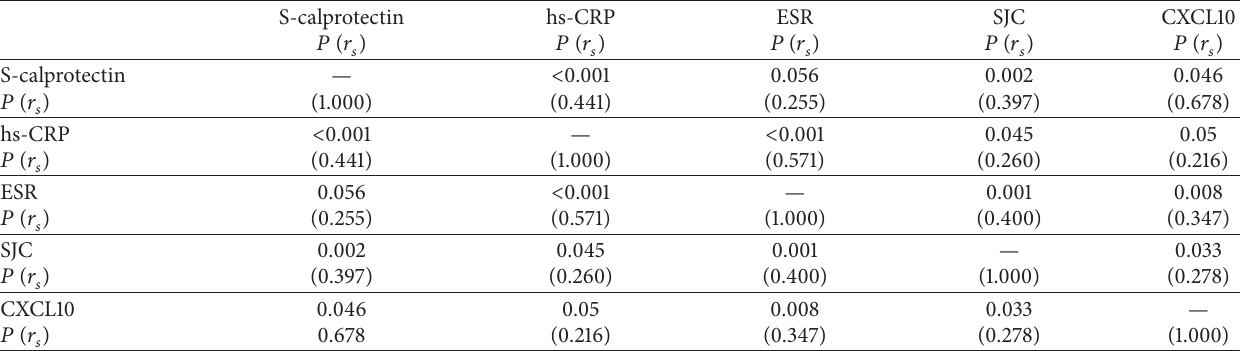
Table 2: Correlations between S-calprotectin, hs-CRP, ESR, swollen joint count (SJC), and CXCL10 analysed with Spearman rank-order